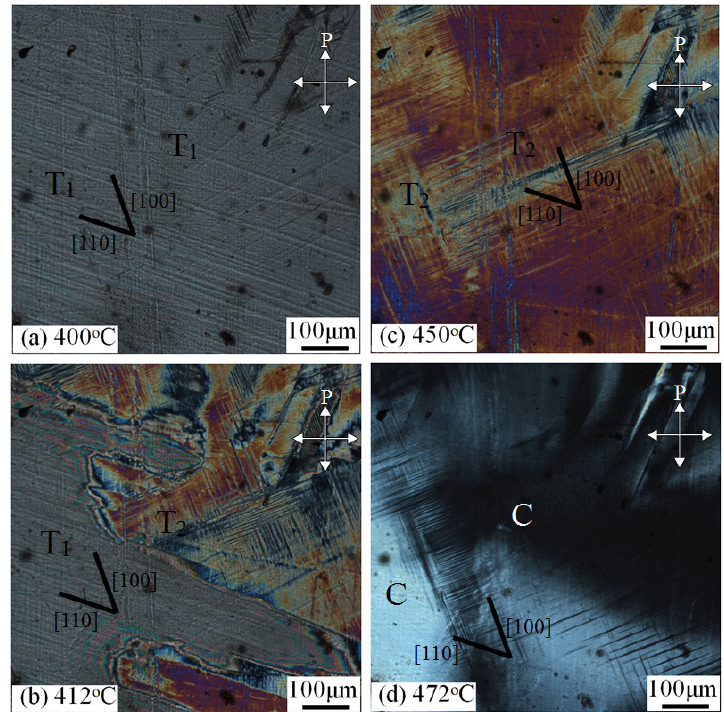
Na )NbO 0.17 0.83 3